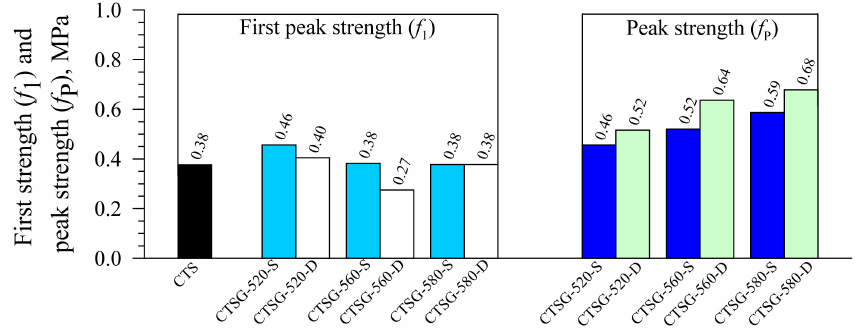
Figure 7. First peak and peak